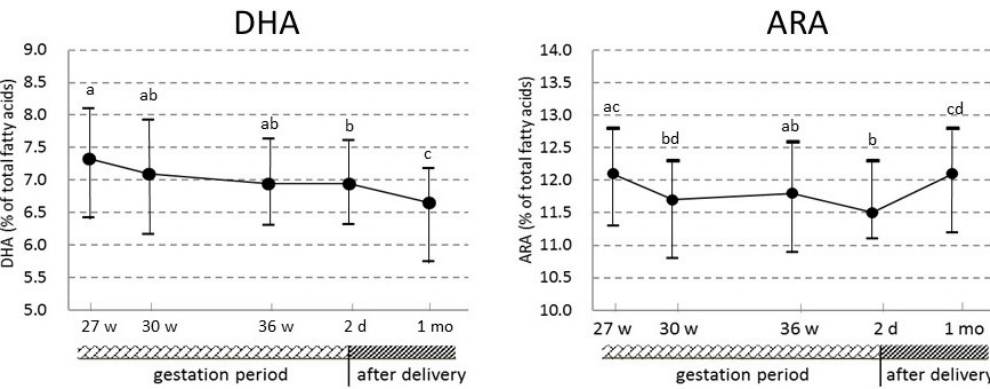
Figure 1. The changes in docosahexaenoic acid (DHA) and arachidonic acid (ARA) levels in maternal erythrocytes during gestation and after delivery. Values are expressed as medians (inter-quartile range) ( n = 74). The longitudinal changes in maternal status were examined by Friedman’s test ( p values), and a post hoc analysis was conducted to identify significant differences between each blood sampling period using the Wilcoxon rank-sum test with Bonferroni correction. Median values indicated by dissimilar letters are significantly different ( p < 0.05).